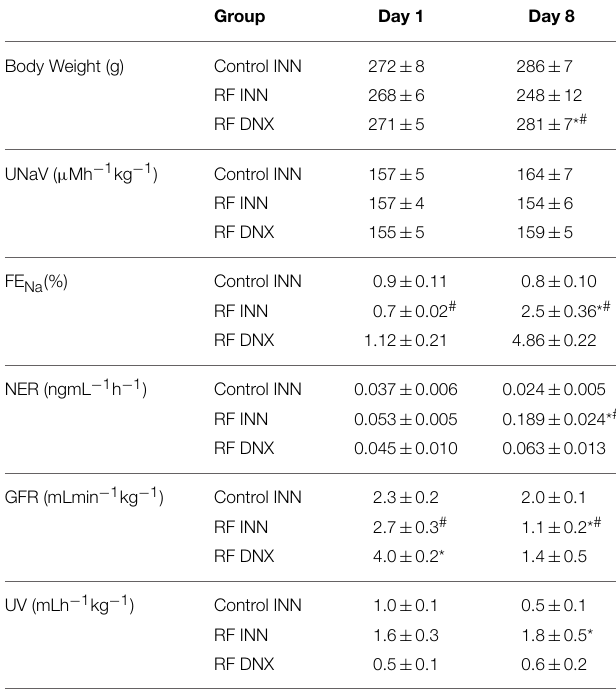
TABLE 1 | Metabolic data in all experimental groups of renal failure (RF), with (DNX) or without (INN) renal denervation, and control